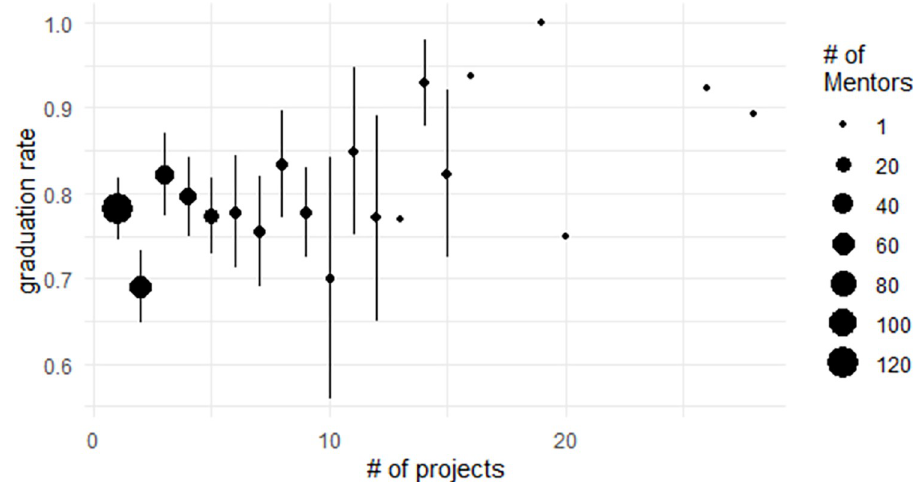
Fig 3. Average graduation rate for mentors who have mentored a given number of projects.